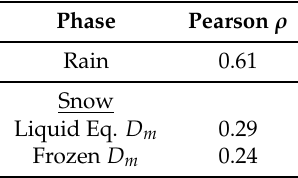
Table 5. Pearson ρ correlation values between log ( R ) and D m for the entire rain dataset and the snowfall measurements in Finland.